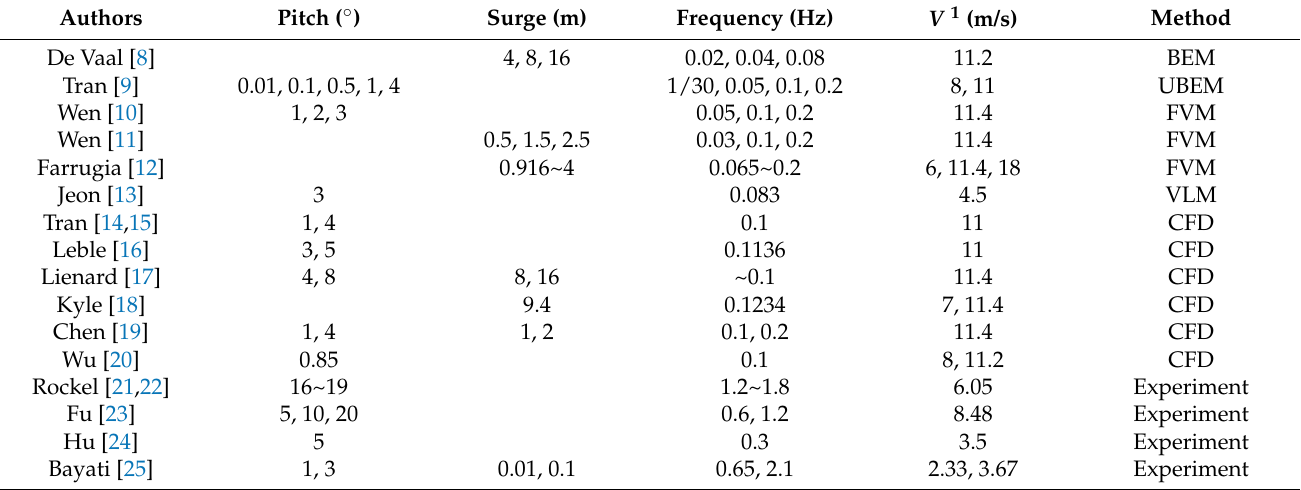
Table 1. Publication related to the analysis of pitch and surge motion of the wind